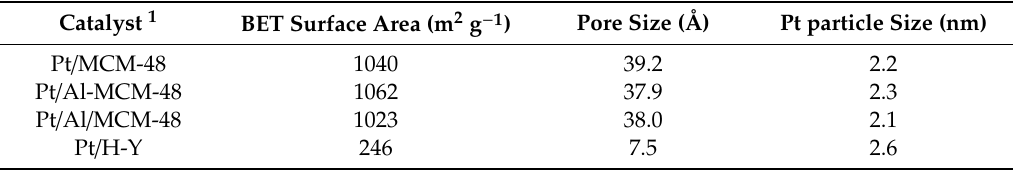
Table 1. Physical properties of various Pt-supported catalysts.